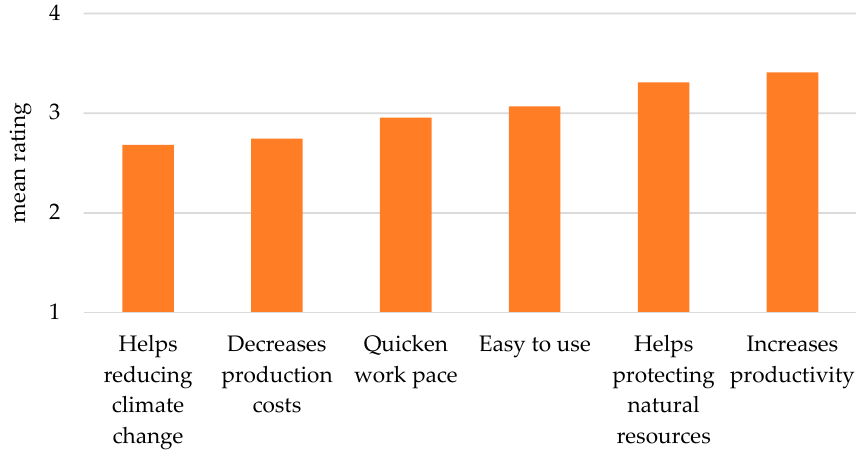
Figure 1. Mean rate of agreement with different statements regarding the use of soil organic matter.